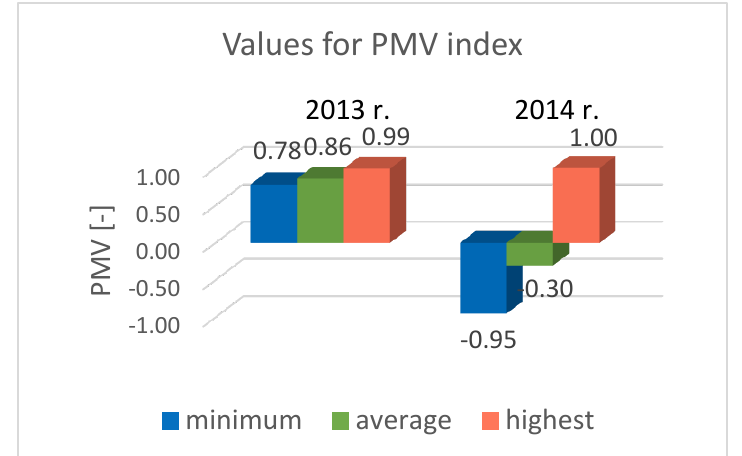
Figure 9. Values of thermal comfort indicators as calculated.